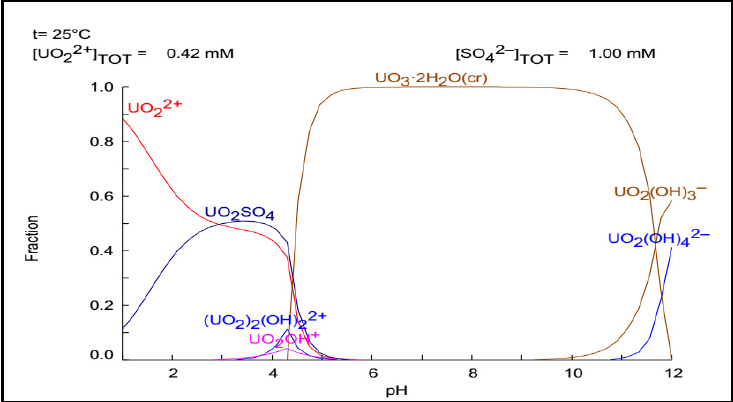
Figure 4. The HYDRA − MEDUSA diagram of uranyl ions at di ff erent pH